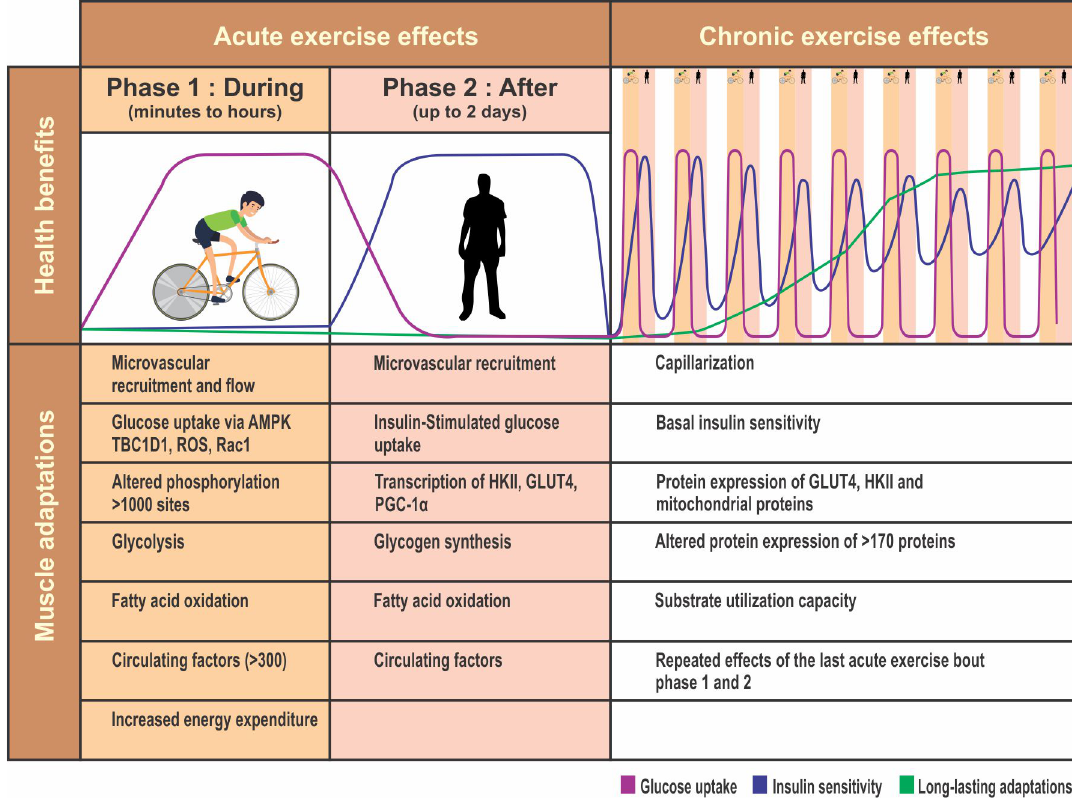
Figure 3. Benefits of exercise.